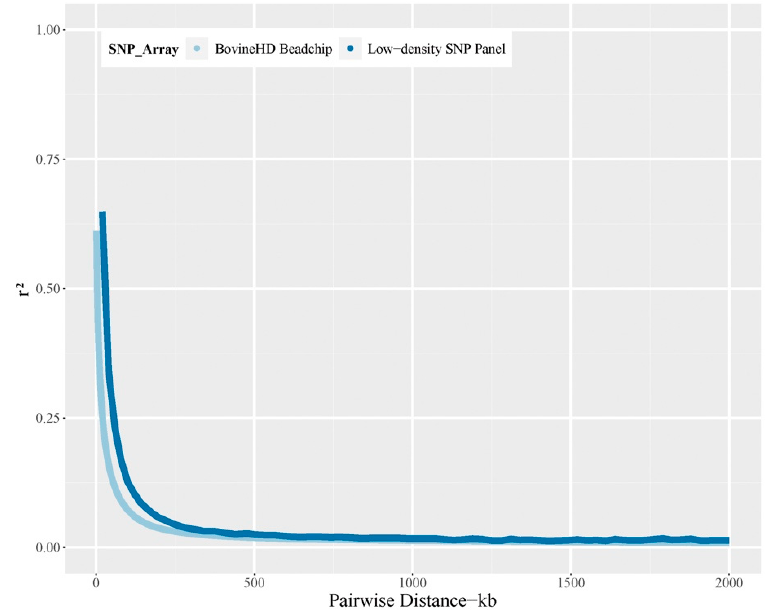
Figure 1. The linkage disequilibrium ( r 2 ) decay patterns for the low-density SNP panel and Illumina BovineHD beadchip within the 2 Mb window.